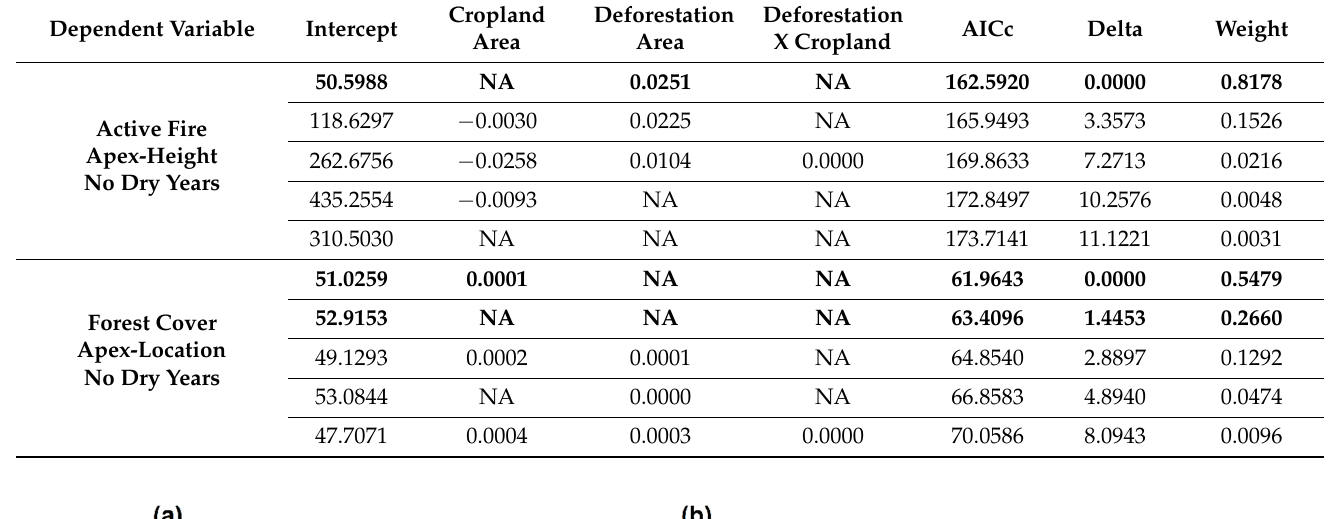
Table A3. Predicted models for the active fire apex-height and forest cover apex-location models. These analyses considered deforestation rates and cropland area as independent variables. In these models, we removed the years with severe droughts (2005, 2010, 2015 and 2016). The results are ranked by the AIC of each function.